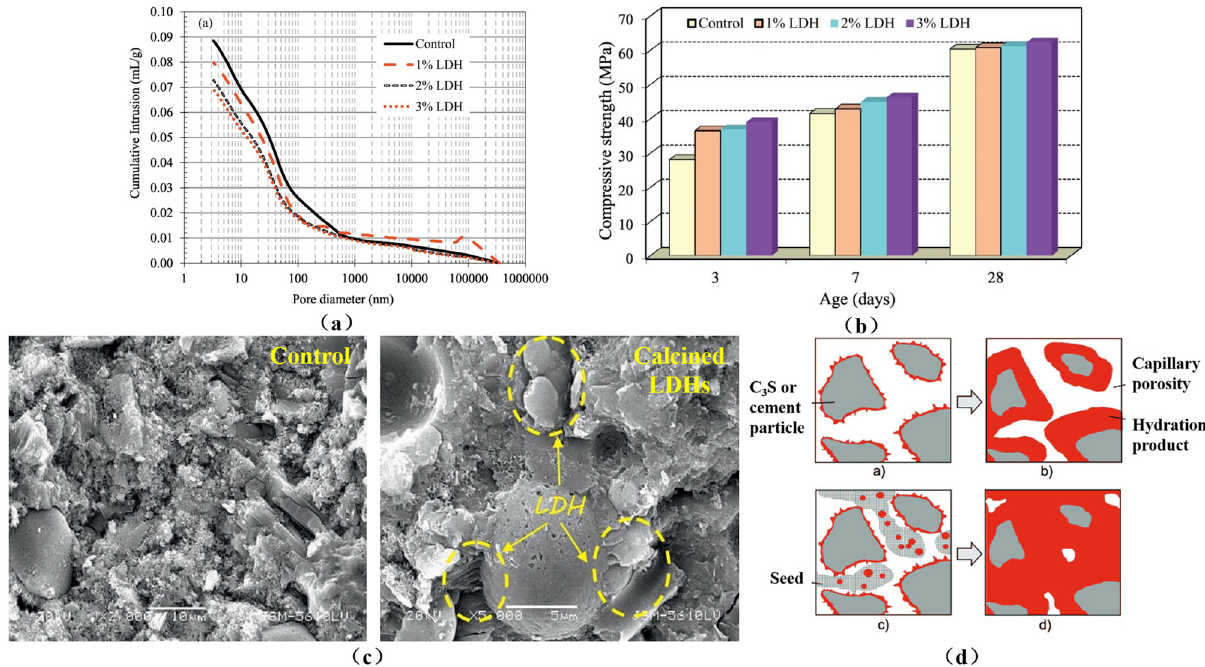
Figure 8: ( a ) Porosity of LDHs blended cement pastes after 28 days of curing. ( b ) Compressive strength of cement containing LDHs at 3, 7, and 28 days. ( c ) E ff ects of LDHs on the microstructure of cement pastes [ 106 ] . ( d ) Schematic of the hydration process [ 115 ]